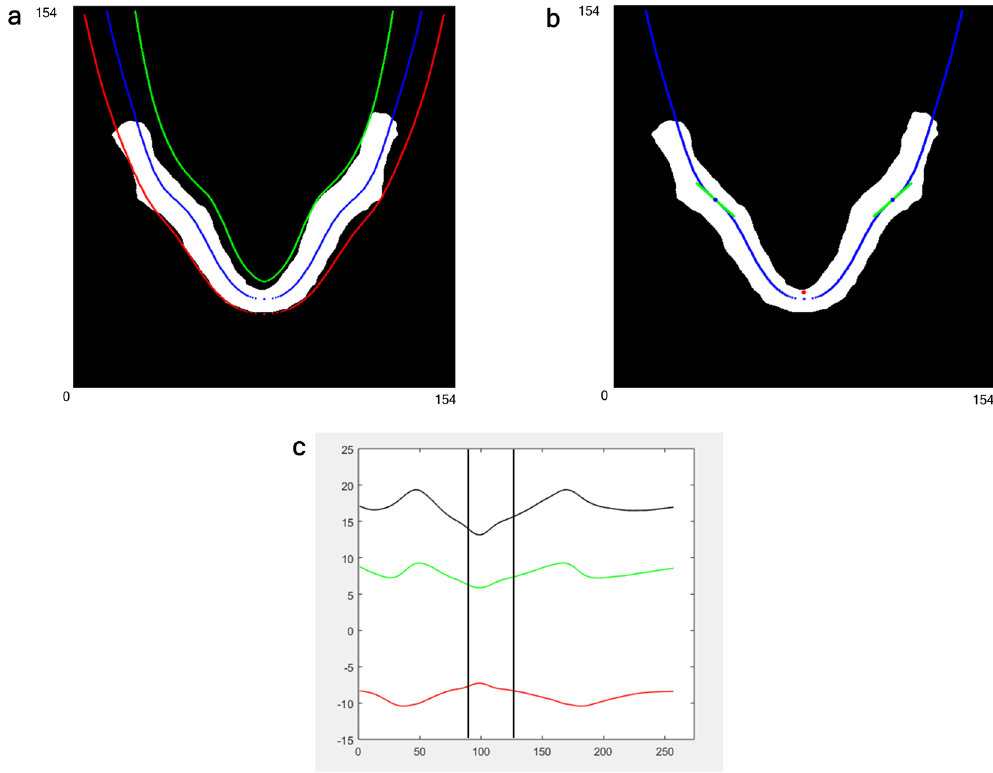
Figure 7. Center, boundaries, and minimum thickness of the panoramic focal trough. ( a ) The fitted center and boundaries of the focal trough using the average arch shape. Each blue, red, and green curve represents the center, buccal, and lingual boundaries of the focal trough, respectively. ( b ) The location (blue points) and slope (green segments) of the transition were obtained using the second and first derivatives of the center of the focal trough, respectively. The red point represents the center of the bilateral contact points of the canines. ( c ) Buccal and lingual boundaries of the focal trough were stretched for the central of the focal trough to become a straight line for obtaining the minimum focal trough thickness. The range of the x-axis is the length of the mandible. The black curve represents the distance (thickness) between the 2 boundaries. Two black vertical lines represent the position of the distal contact points of the bilateral canines. Unit: